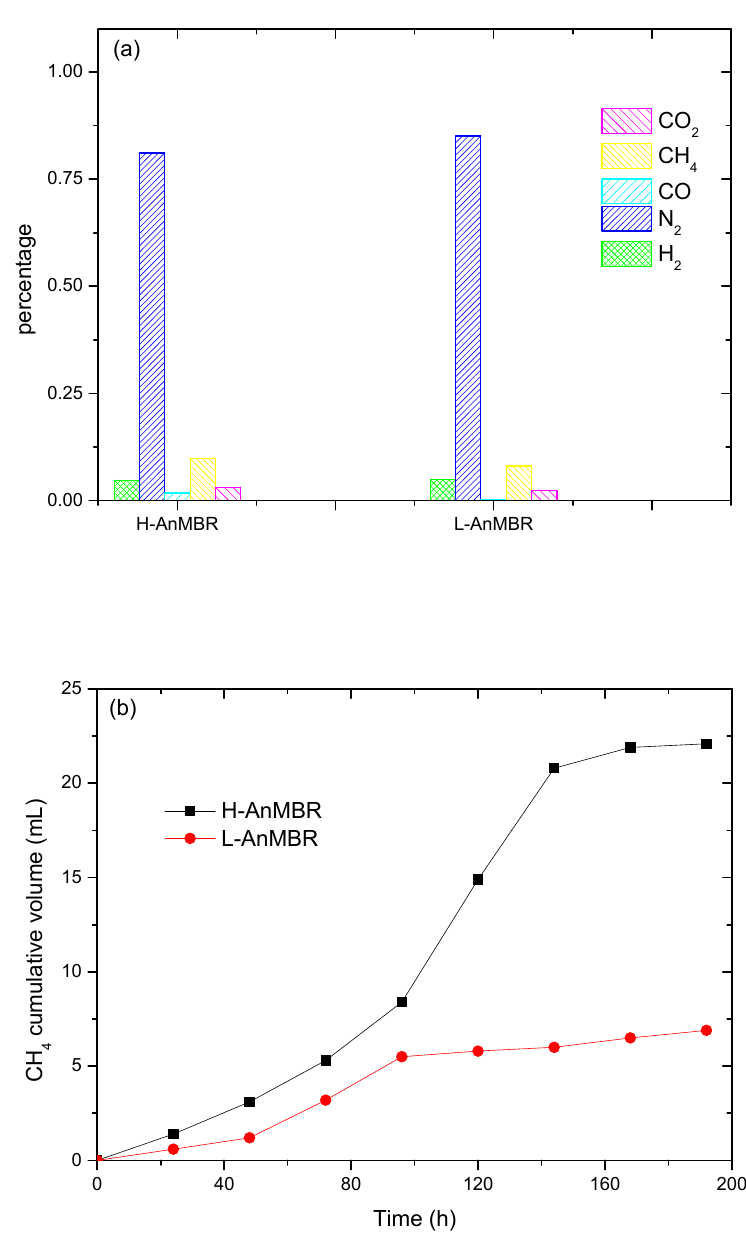
Figure 2. The gas composition ( a ) and the cumulative methane content ( b ) in the H-AnMBR and L-AnMBR.